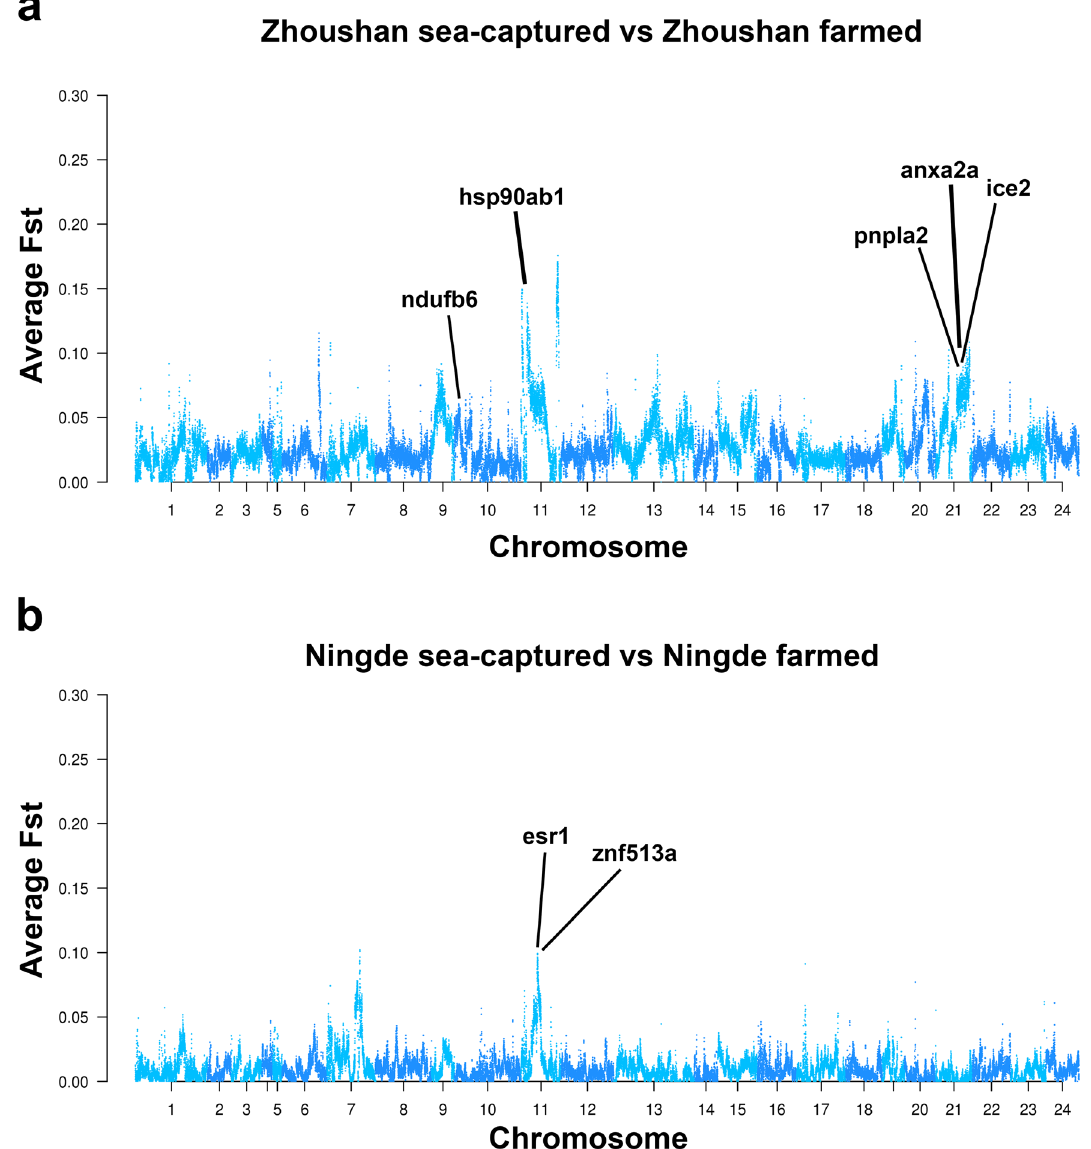
Figure 5. Genomic regions associated with domestication of large yellow croaker between Zhoushan sea or Ningde sea. ( a ) Manhattan plot for average Fst values in 40 kb windows with 10 kb steps between Zhoushan sea- captured and Zhoushan farmed. ( b ) Manhattan plot for average Fst values in 40 kb windows with 10 kb steps between Ningde sea-captured and Ningde farmed. The x-axis represents chromosomal positions and the y-axis represents the average Fst